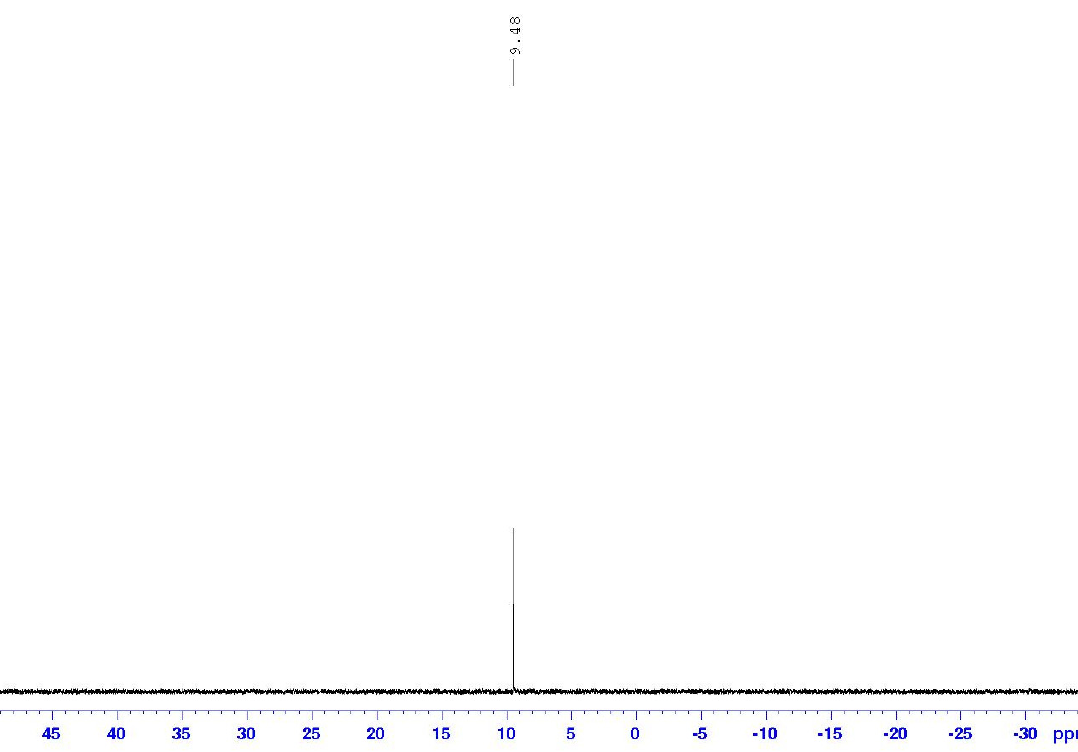
6 ) of compound 4a